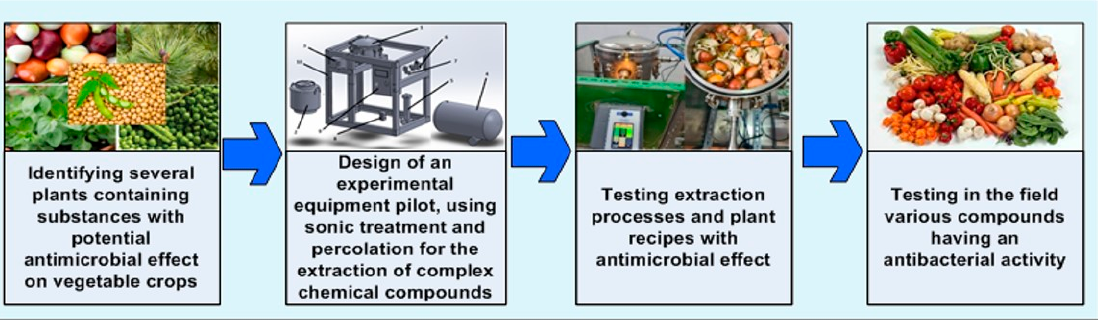
Figure 1. Phases in technology development for producing bioactive compounds applied to sustain- able agriculture.